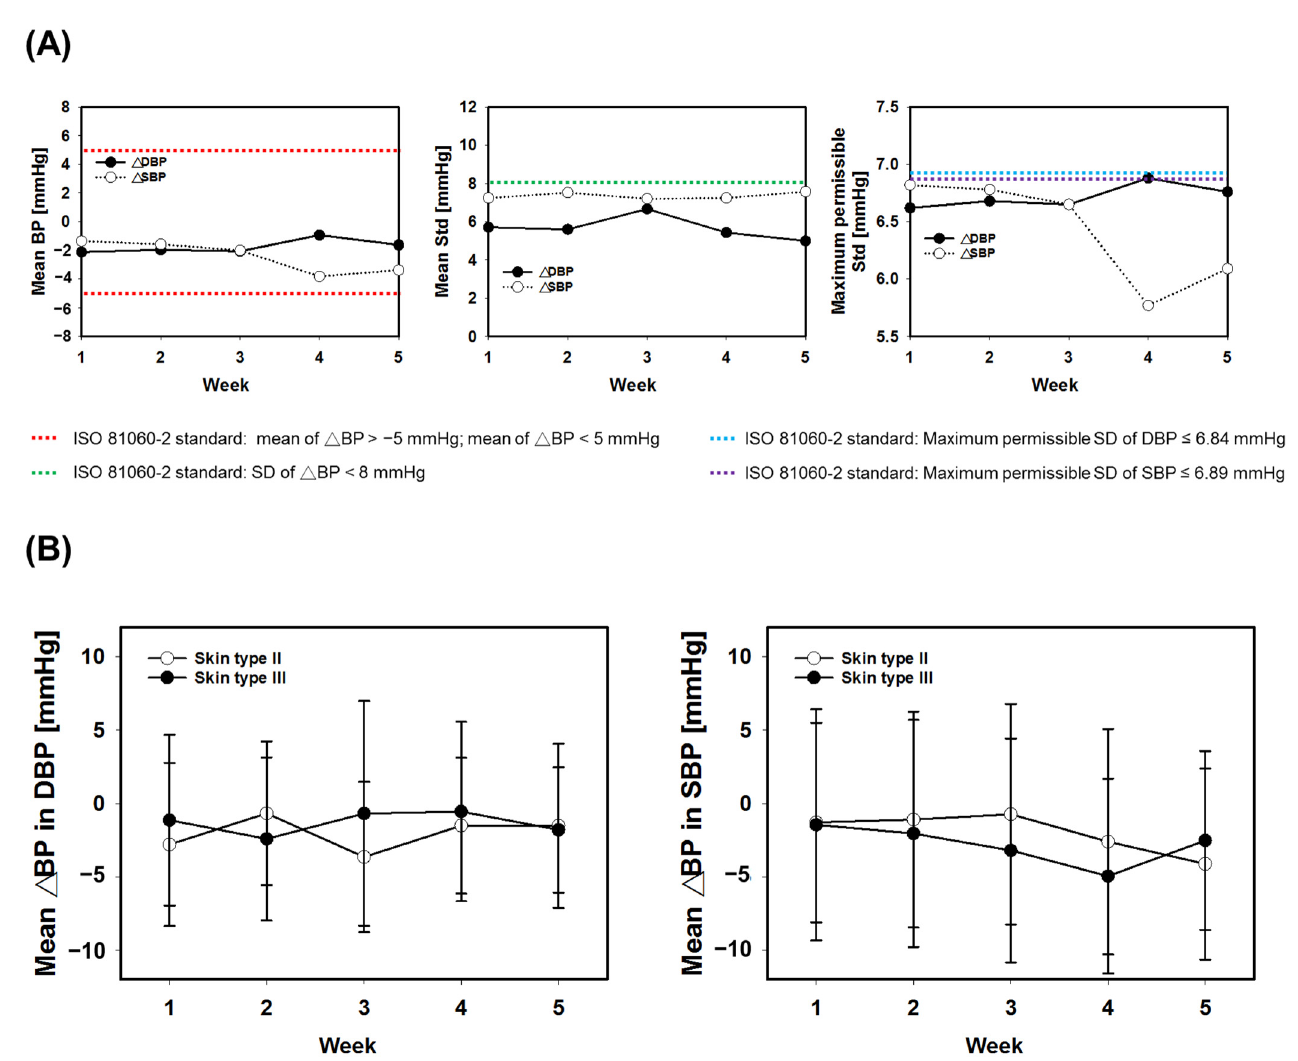
Figure 9. ( A ) Comparison of the ISO standard and cuffless BP estimation of long-term follow-up error, shown for the first week, second week, third week, and fourth week and for 1 month after the first-week calibration process, respectively. Dotted lines indicate ISO standard criteria (red dotted line: mean ∆ BP; green dotted line: mean SD of ∆ BP; blue dotted line: maximum permissible SD of DBP; purple dotted line: maximum permissible SD of SBP ≤ 6.89 mmHg). ( B ) Statistical comparison of mean ∆ BP in SBP and DBP between the different skin phototypes (Fitzpatrick skin type II and type III). All results were not statistically different. Table 2. Performance evaluation for ∆ BP and the cumulative percentage of ∆ BP over a 1-month period (5 weeks).